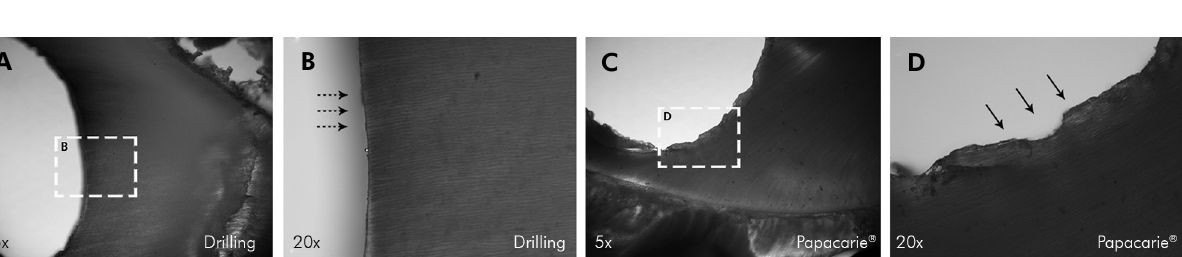
(A,B) Images of the drilling group at 5x and 20x magnification, respectively. (C,D) Images of the CMCR group at 5x and 20x magnification, respectively. Dashed arrow indicates a smooth surface, and solid arrow indicates a rough and irregular surface Figure 2. Polarized light microscopy images of the residual dentin after caries removal.